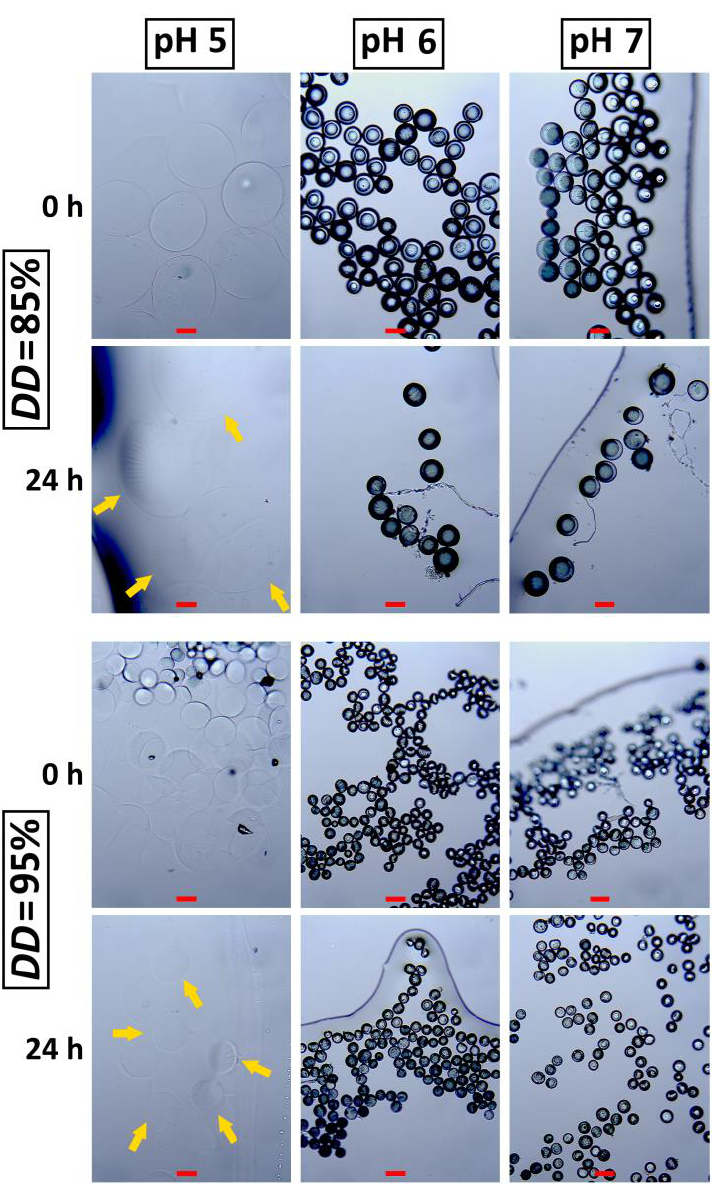
Figure 7. Micrographs of chitosan–Cu5 microspheres immersed in different buffer solutions at 0 and after 24 h. The scale bar is 100 μm.